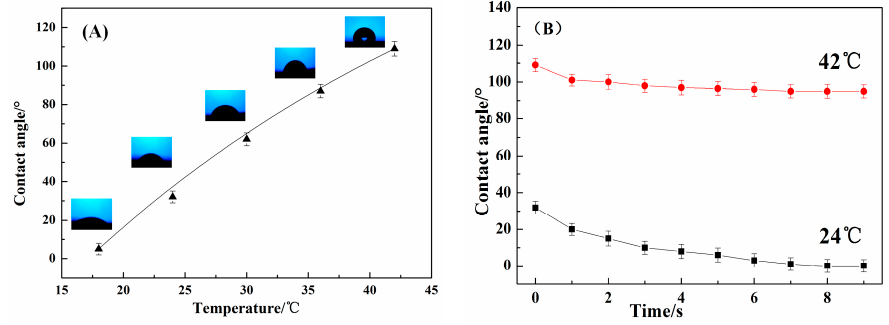
Figure 8. Contact angle measurements of temperature- and pH-sensitivity mulberry silk fabric: ( A ) at different temperature; ( B ) at different time. Data are presented as mean ± standard